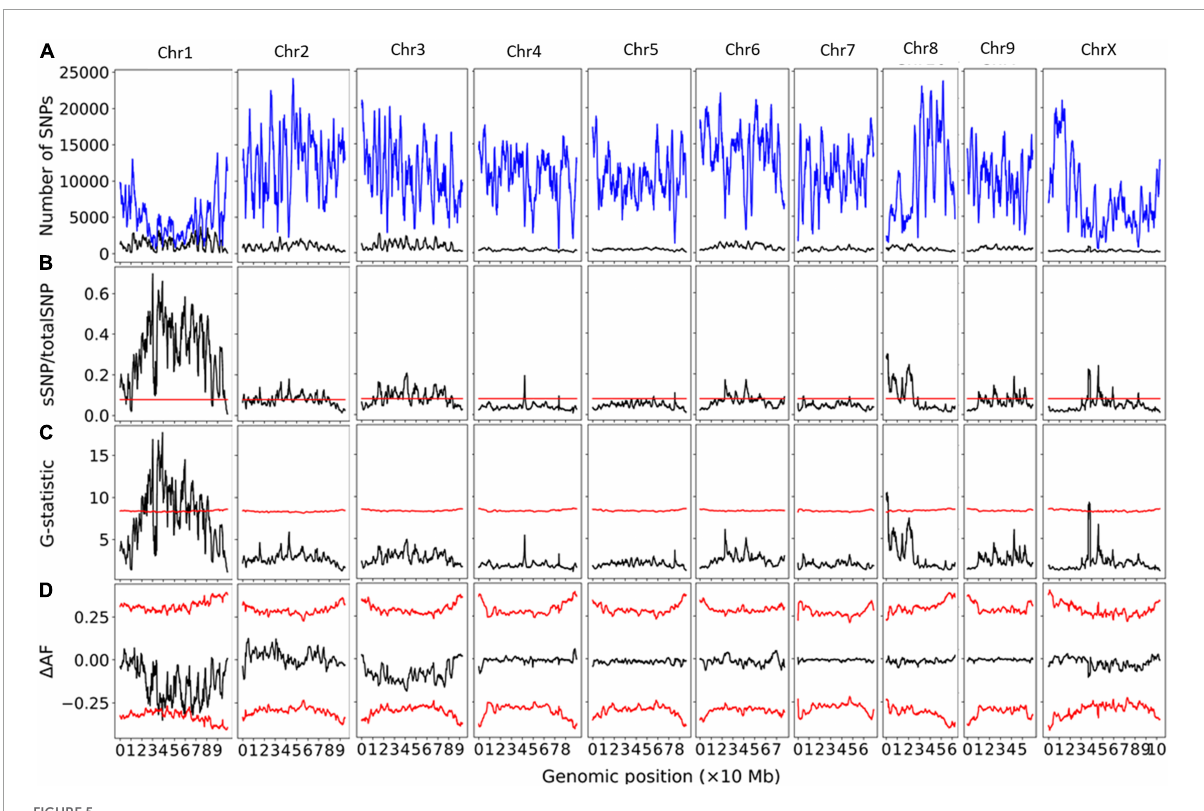
FIGURE5 Bulk segregant analysis for pools of early- and late-flowering plants from ‘Umpqua.’ Physical genomic window size is 2 Mb and step size is 10 kb. (A) Chromosomal distribution of SNPs. Total SNP number is in blue and significant SNP number (Fisher Exact Test P < 0.01) is in black. (B) Ratio of significant SNPs:Total SNPs across chromosomes. (C) G-statistic values across chromosomes. (D) Delta-allele frequency ( (cid:49) AF) values across chromosomes. Red lines represents significance thresholds determined by simulation of 10000 SNPs given allele depths at the 99.5th percentile for significant SNPs:Total SNPs and G-statistic, and the 99% confidence interval for (cid:49) AF values.